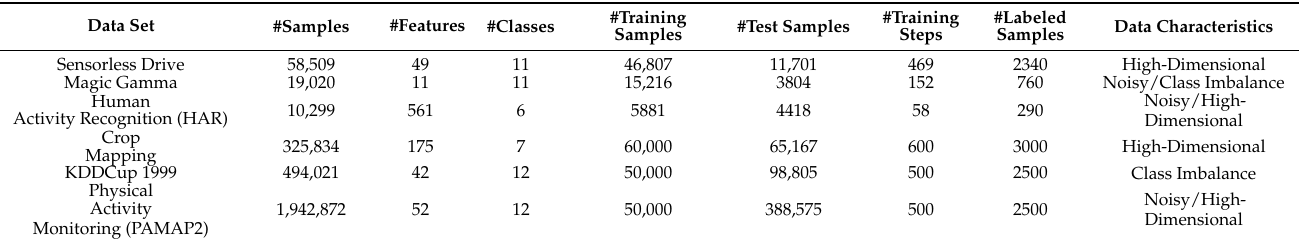
Table 1. Benchmark data